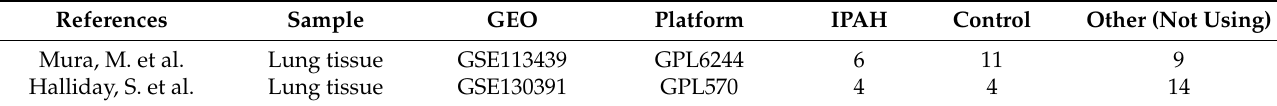
Table 1. Datasets detailed